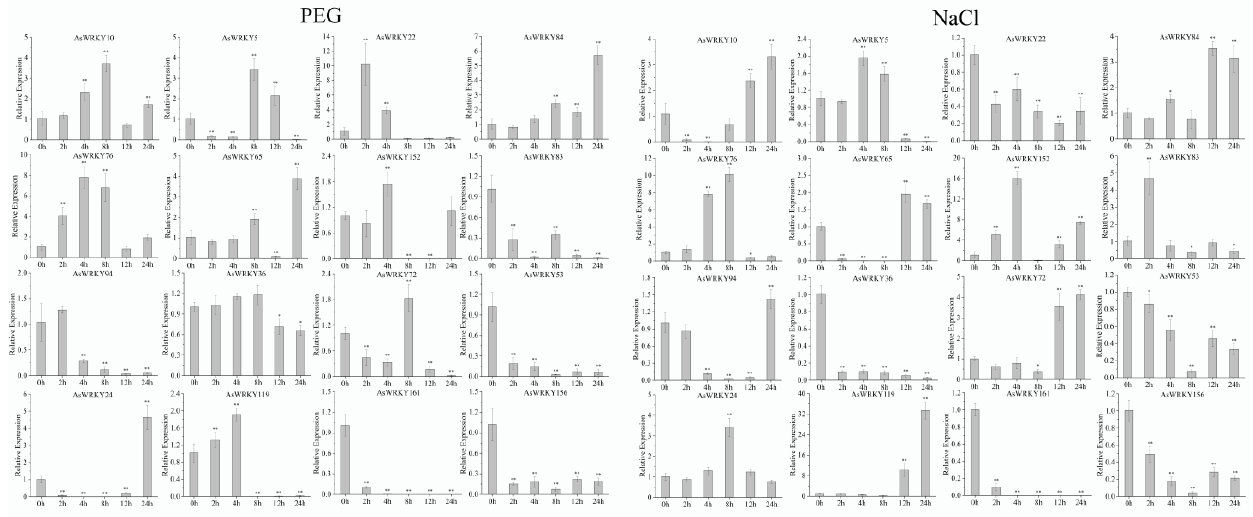
Figure 10. Expression pattern of 16 selected AsWRKY genes in response to drought and salt stress.